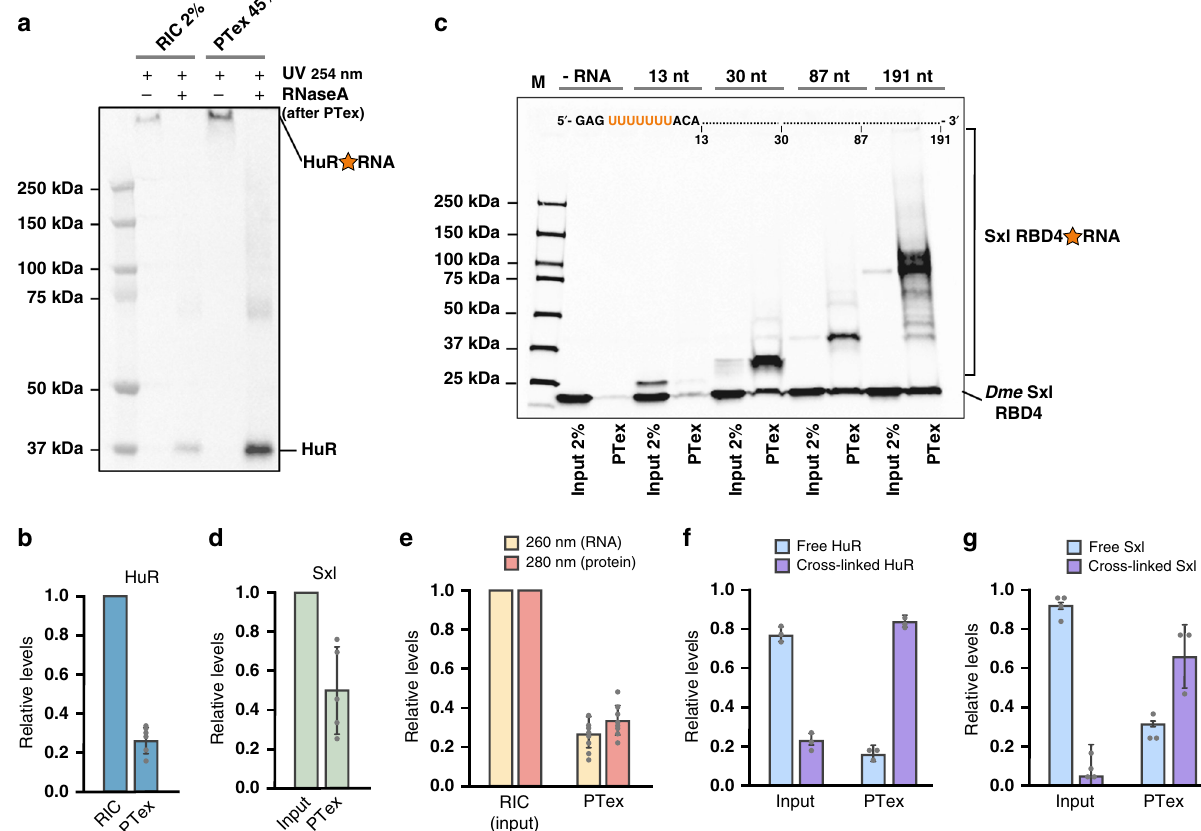
Fig. 2 Performance of PTex. a RNA interactome capture of HEK293 was used as 100% cross-linked input material and HuR recovery by PTex was assessed. b Quanti fi cation of a (HuR n = 6 biologically independent experiments). c Drosophila melanogaster RBP Sxl RBD4 was bound to RNA of several length carrying the Sxl U7 recognition site and UV cross-linked in vitro; minimal RNA length for ef fi cient recovery by PTex is 30 nt. d Quanti fi cation of c ( n = 5 biologically independent experiments). e PTex recovery of RNA (260 nm) and proteins (280 nm) determined by UV spectroscopy ( n = 9; 5 biologically independent experiments; 2 of those with 3 technical repeats each). f , g Relative enrichment of cross-linked HuR (source Fig. 1c) and Sxl (source Fig. 2c, n = 3 biologically independent experiments) by PTex. Error bars represent SD. All data are in Supplementary Data 4. For full blots see